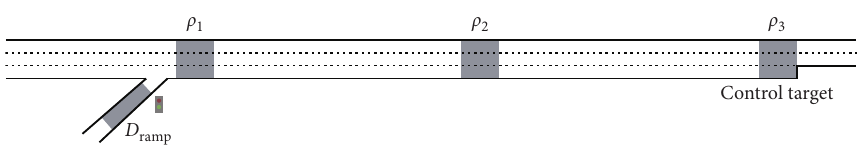
Figure 1: The formulated Q-learning problem having four state